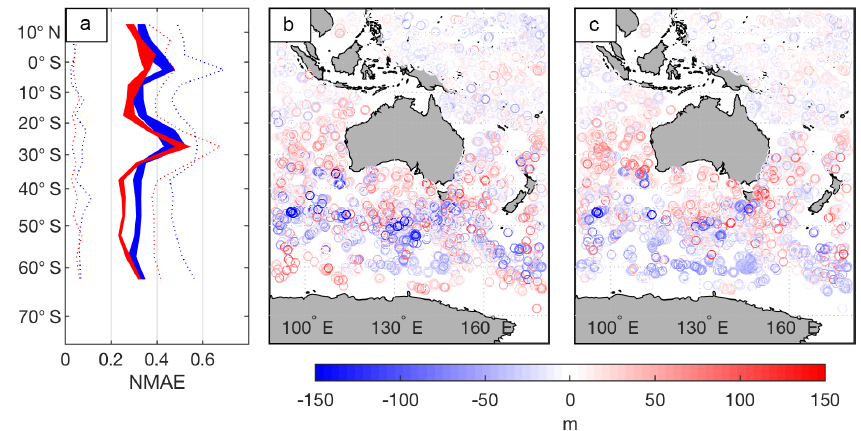
Figure 4. (a) The normalised mean absolute error (NMAE) of the OceanMAPS 2.2.1 (blue) and 3.0 (red) MLD corresponding to Class 4 profiles over the study period. The range of values between forecast time steps ( + 0h, + 24h, + 48h etc.) is indicated by the line thickness. The 5th and 95th percentiles for each model are shown by the dotted lines. The absolute error at model time + 24h are shown in (b) for version 2.2.1 and (c) for version